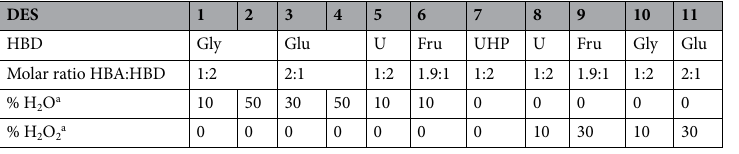
Table 1. List of the DES used in this study. Hydrogen bond acceptor was choline chloride for all DES solutions. a Water or hydrogen peroxide content (%,